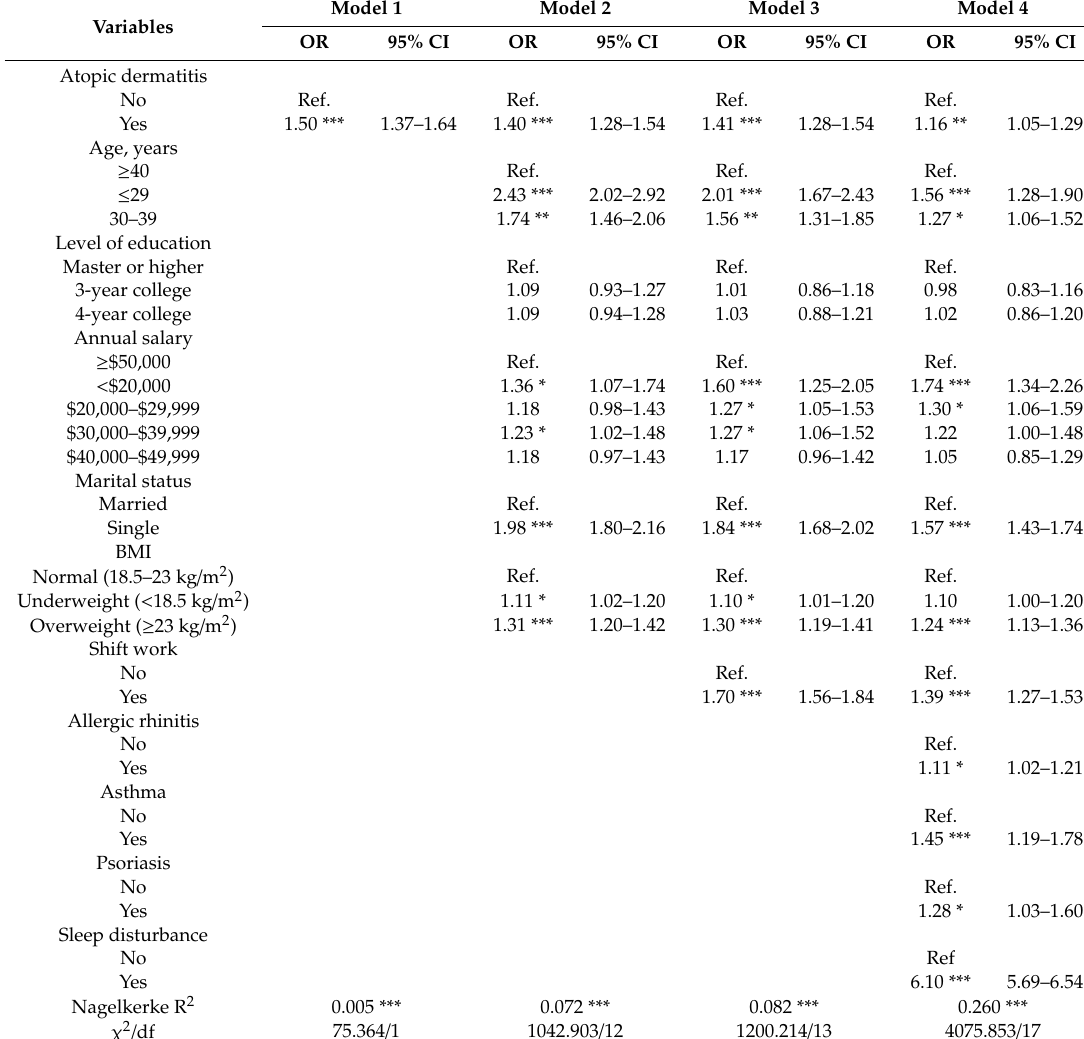
Table 3. Odds and 95% confidence interval for depressive symptoms in the multivariate logistic regression analysis ( N = 20,613).